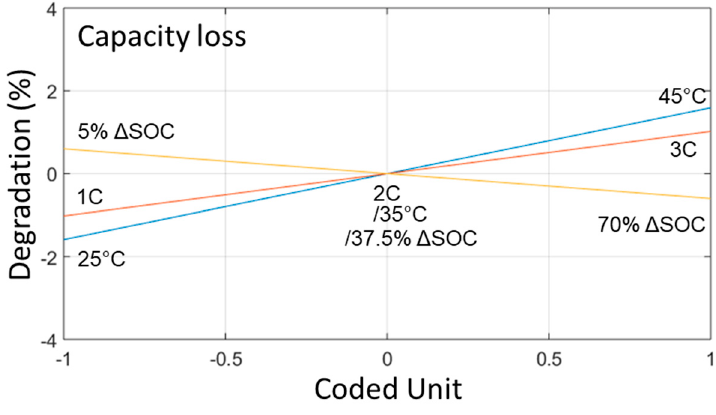
Figure 9. Example of a significance analysis taken from [70] .